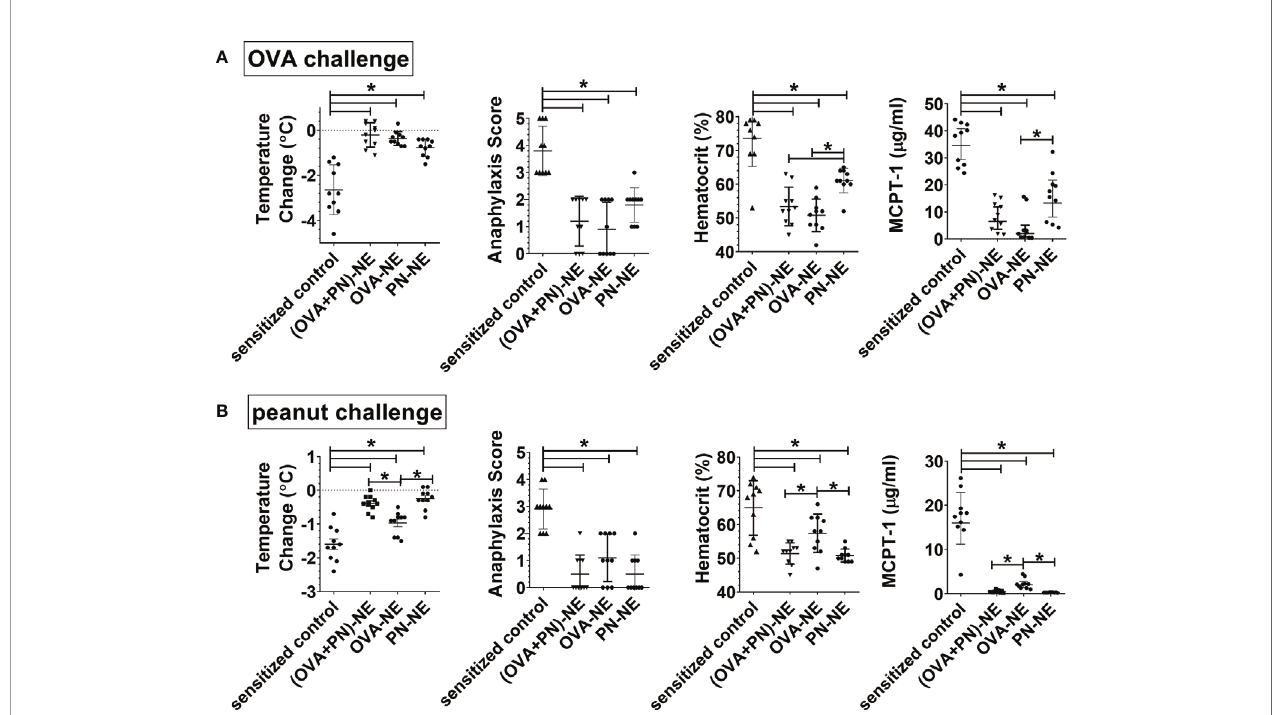
FIGURE 2 | Immunization of polysensitized mice with NE and one allergen provides protection against reactivity to another allergen. As described in Figure 1A, mice were sensitized with OVA and peanut-alum and treated i.n. with 3 administrations of PBS (sensitized control), ova and peanut-NE (OVA+PN-NE), OVA-NE or peanut- NE (PN-NE). Mice were challenged orally with (A) OVA or (B) peanut and temperature change and symptoms of anaphylaxis were monitored. Hemoconcentration was determined by hematocrit. Levels of MCPT-1 in the serum 60 min after challenge were determined by ELISA. Statistically signi fi cant differences (p < 0.05) are indicated by